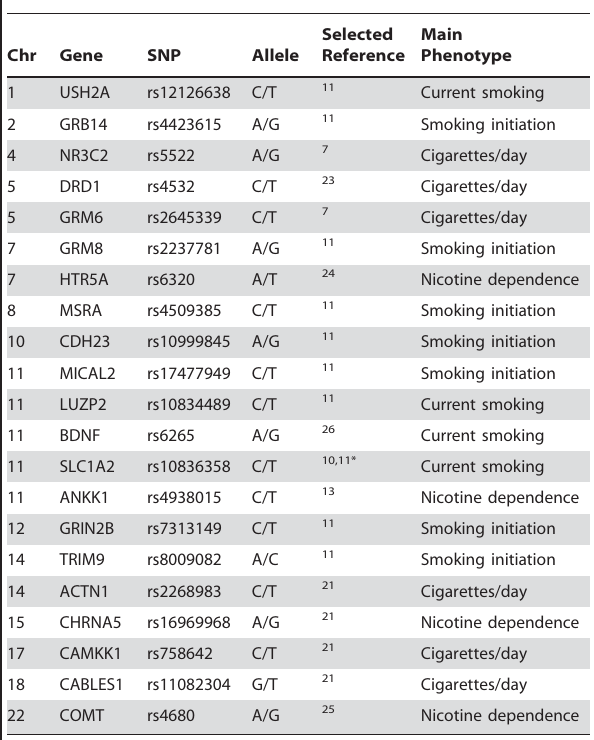
Table 3. Characteristics of SNPs